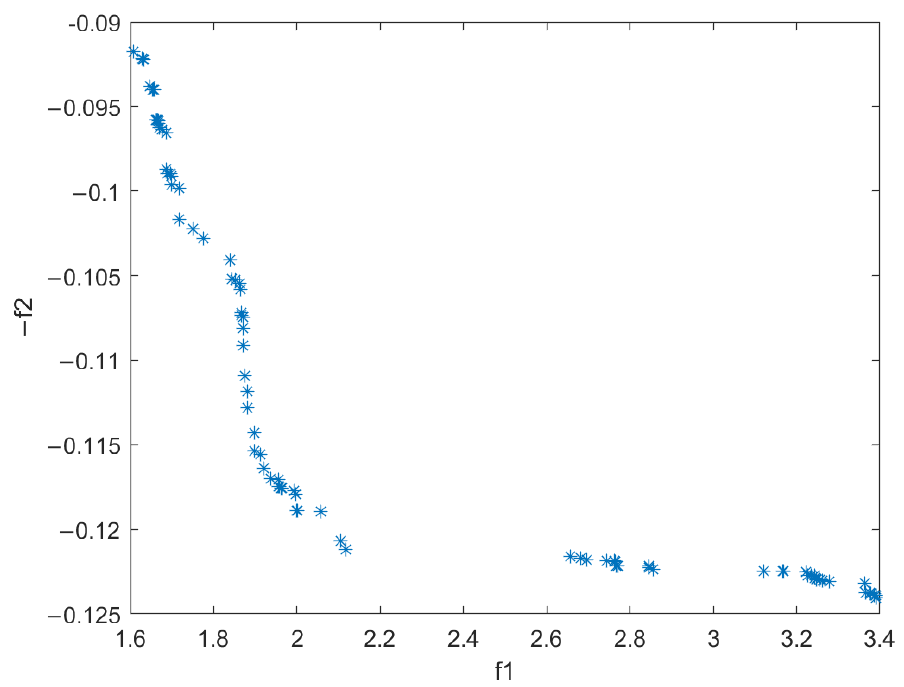
Figure 10. Pareto front.